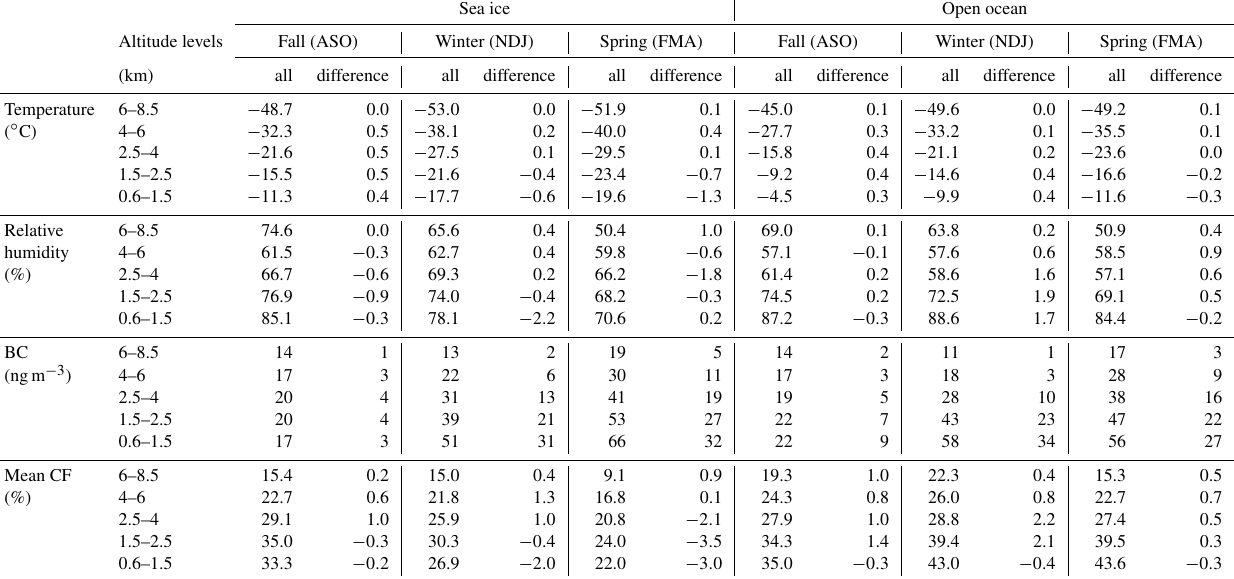
Figure 2. (a–c) CloudSat 2B-FLXHR-LIDAR longwave cloud radiative effect at the bottom of atmosphere (i.e., surface) (LW CRE BOA ) during polar night for (a) the full dataset, and the subsets of data containing the lower (b) and upper (c) quartiles of modeled column BC concentrations. For reference, (d) shows the average winter (November to January) sea ice extent up to 82 ◦ N. Also shown are (e) boxplots of the lower tropospheric stability (LTS, K), and (f) (g) show the median temperature ( T , ◦ C) and relative humidity (RH, %) for the lower (blue) and upper (red) quartile column BC concentrations over open ocean and sea ice. All differences in (e) – (g) are significant ( p <0.0001), based on a Wilcoxon rank test. Table 1. The mean temperature ( T , ◦ C), relative humidity (RH, %), black carbon (BC, ngm − 3 ) , and cloud fraction (CF, %) observed over the Arctic Ocean study region over sea ice and open ocean during different seasons and altitude levels. Data are shown for all conditions. Also shown are the mean differences between all minus clean conditions (difference) for T , RH, BC, and CF, referred to as dT , d RH, d BC, and d CF in the text. Sea ice Open